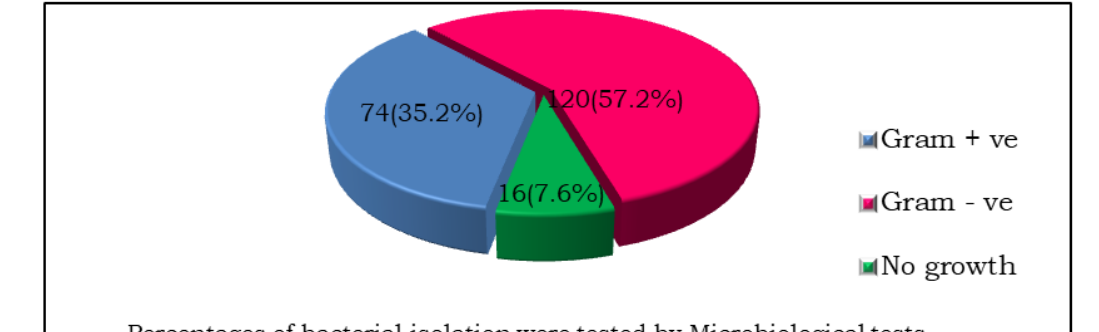
Fig. 1. The percentage of bacterial isolation from the lower respiratory tract infections